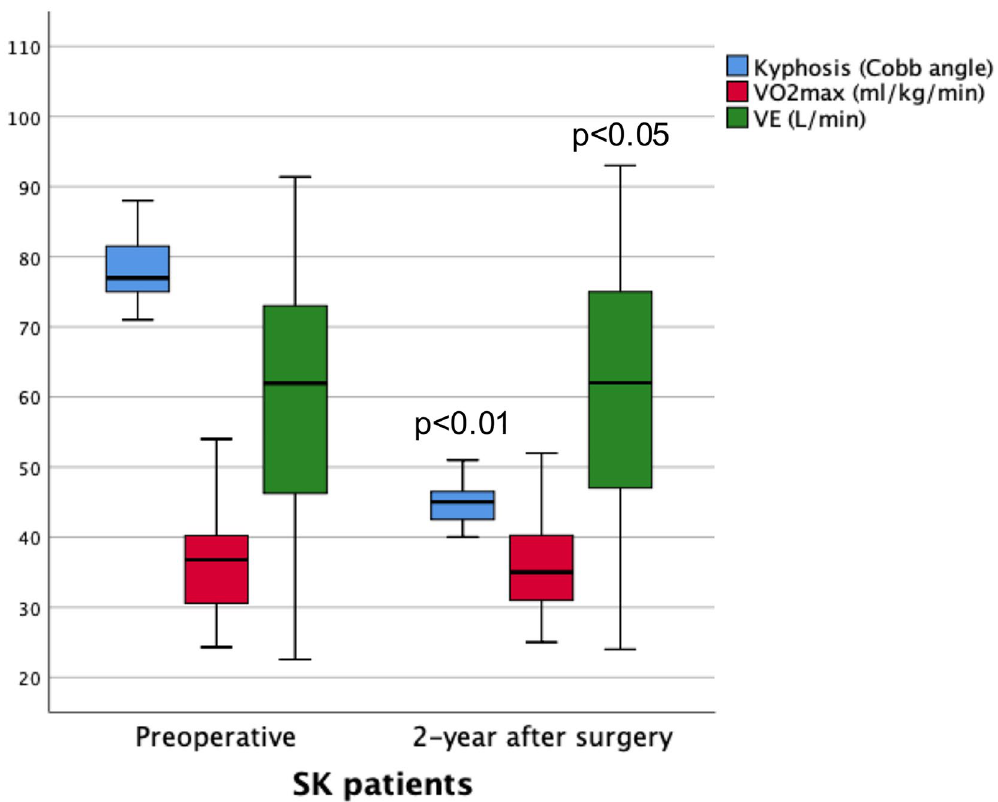
Figure 4. Magnitude of the thoracic kyphotic, maximal aerobic power (VO 2 max in ml/min/kg) and maximal ventilation (VEmax in L/min) in SK patients before and 2-year after